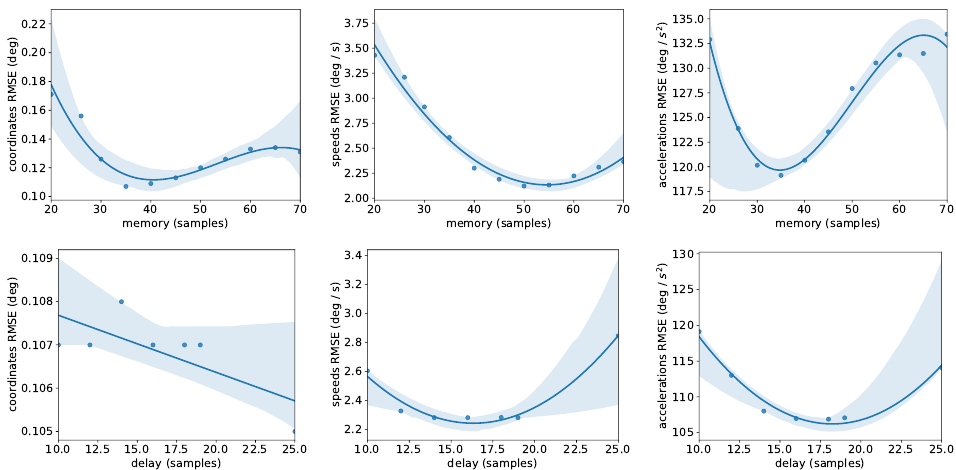
Figure 6. RMSE between OpenSim ’s offline kinematics analysis and proposed filter as a function of the decision variables ( M and D ). We selected the smallest values that resulted in the lowest error in the